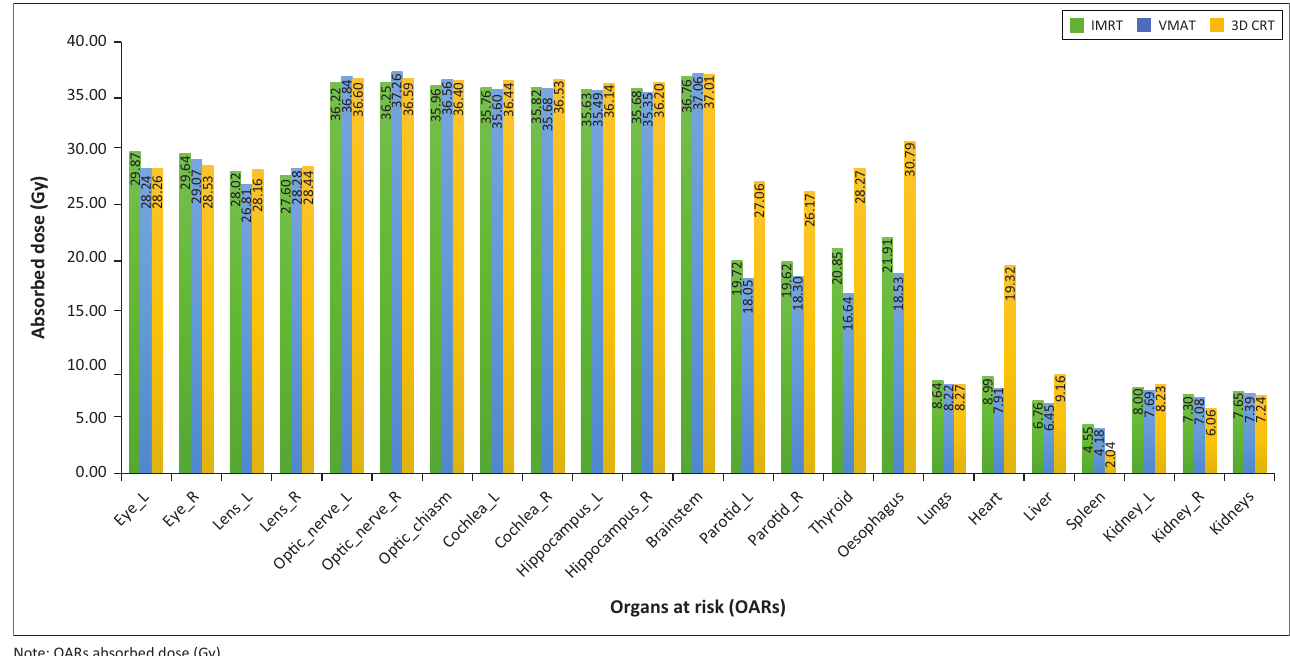
Note: The duration for each process as recorded in Table 6 is an average of the time recorded for each of the seven patients. RT, radiation therapy; IMRT, intensity-modulated radiation therapy; VMAT, volumetric modulated arc therapy; 3D CRT, 3D conformal radiation therapy.